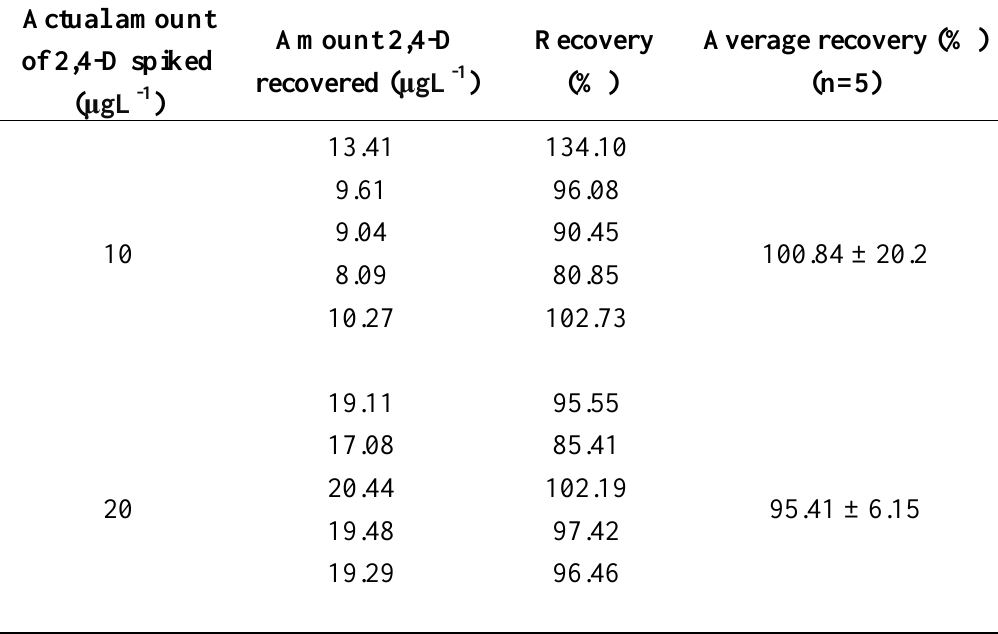
Table 3. Average recovery values for 2,4-D spiked in the water samples from rice